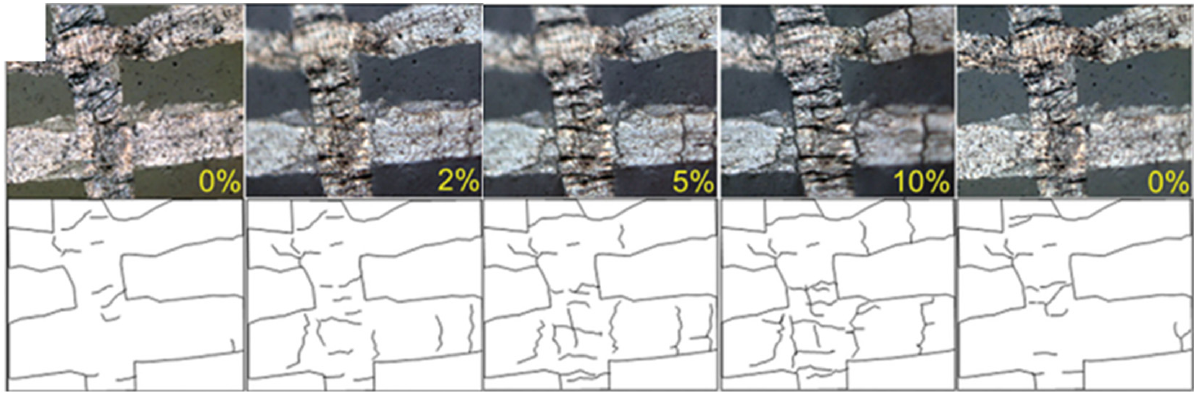
Figure 5. Crack propagation under SEM view: microcrack propagation on the graphene–PDMS composite film under stretching [54] (Copyright 2012, the authors).